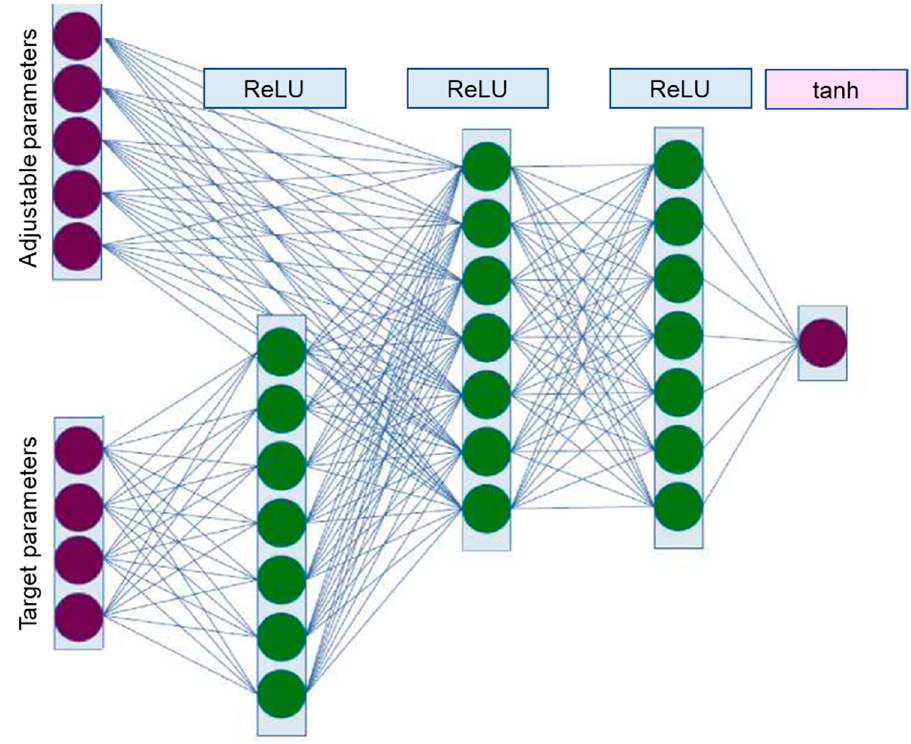
Figure 6. Architecture of the neural network for the assessment module.